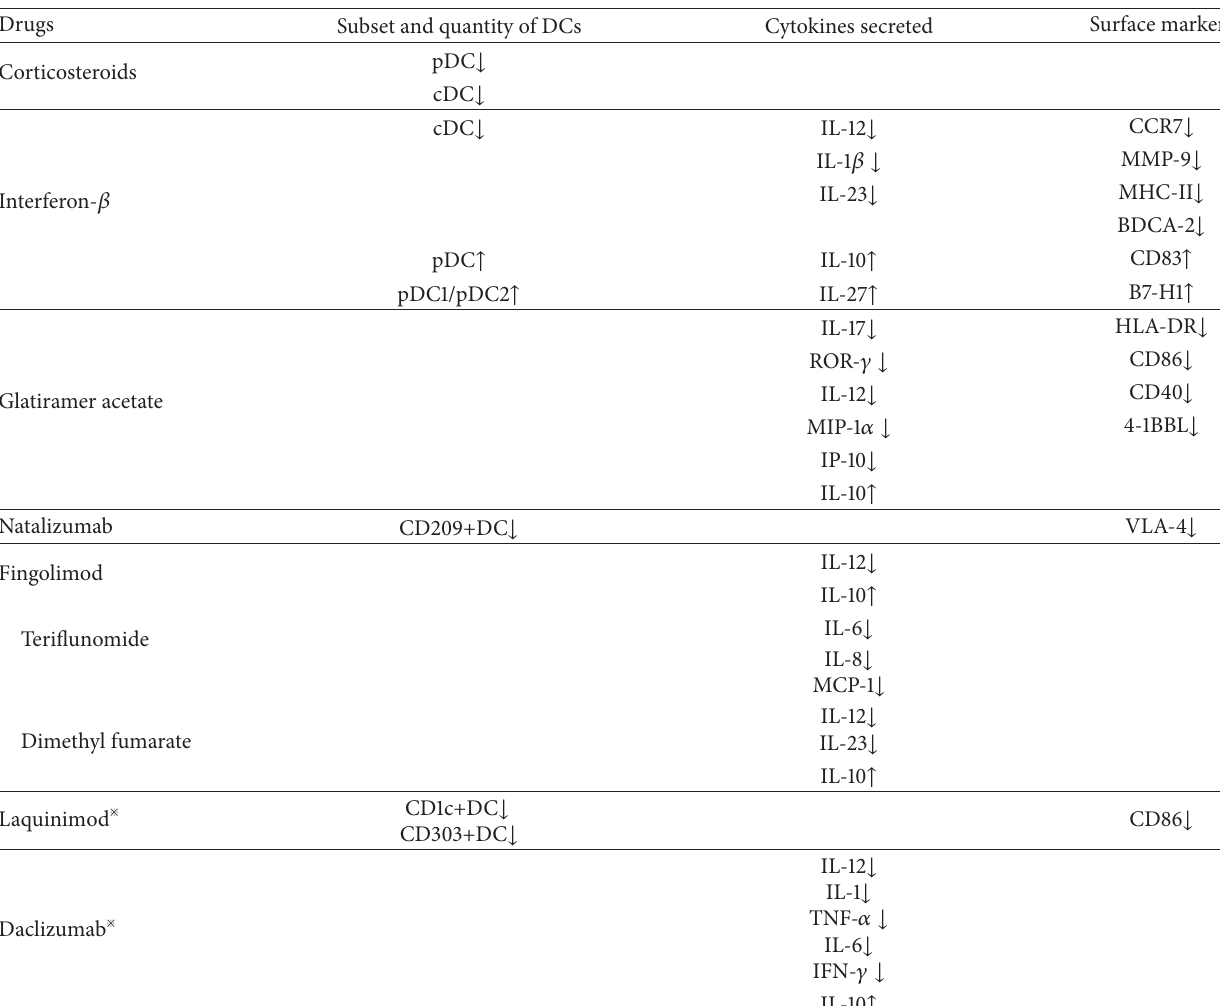
Table 2: Effects of current therapeutic options on DCs in multiple